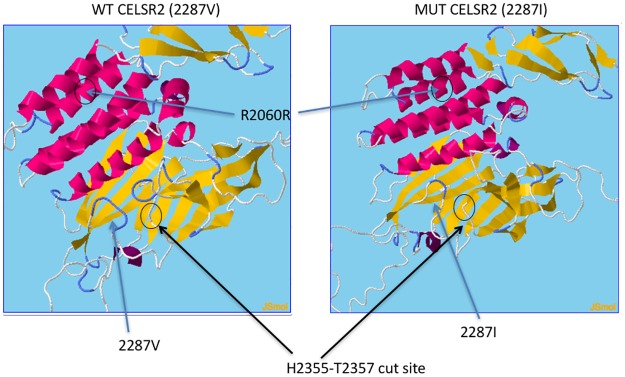
Visualisation of the predicted structure of the GAIN domain of CELSR2.The left panel shows the wildtype 2287V form, the right panel shows the mutated 2287I form. The location of the V2287I and R2060R variants are shown, as well as the site of autoproteolytic cleavage.